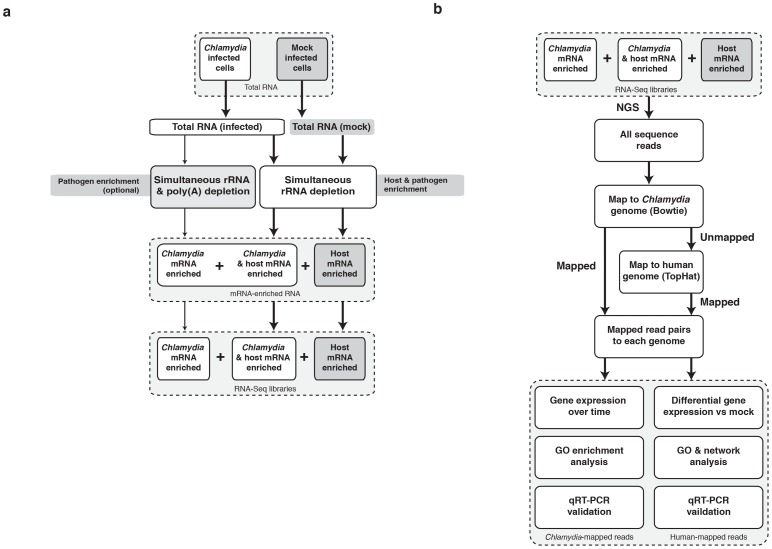
The simultaneous RNA-Seq pipeline.(a) Laboratory pipeline for simultaneous depletion of rRNA from prokaryotic and eukaryotic RNA mixtures. The enriched mRNA is used to create RNA-Seq libraries. (b) Bioinformatics pipeline for sequential mapping and analysis of simultaneous RNA-Seq data.